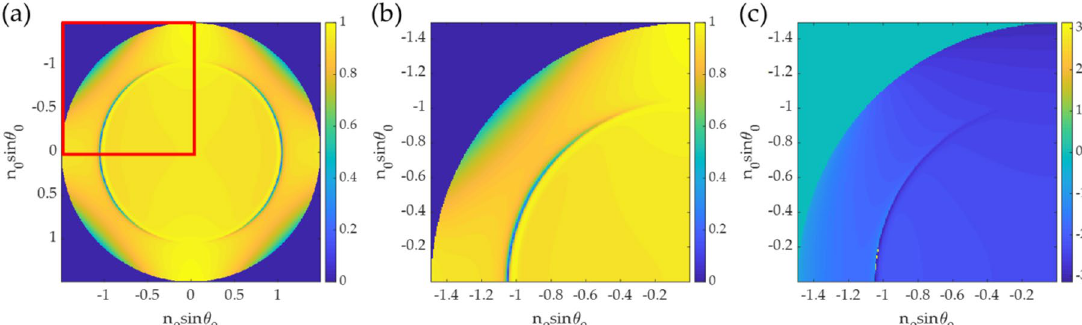
Figure 4. Simulated data for n 0 of 1.52, n m of 0.18 + 3.44i, d m of 45 nm, n s of 1.00, and l 0 of 633 nm for ( a ) full BFP amplitude image (512 × 512 pixels) before cropping, ( b ) BFP amplitude input (256 pixels × 256 pixels), and